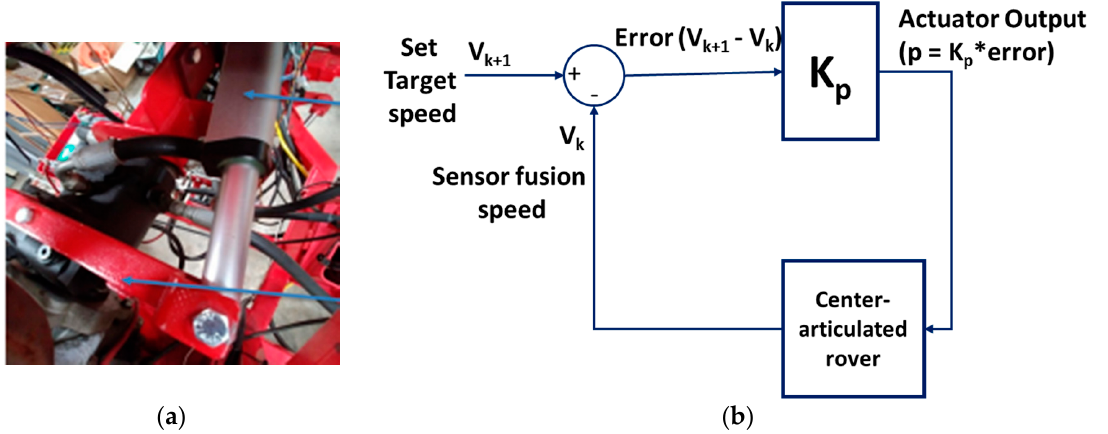
Figure 12. ( a ) The arrow points to the red arm that controls the swashplate angle. Another arrow points to the grey linear actuator controlled by the navigation controller ( b ) The proportional control diagram of the speed of the rover.